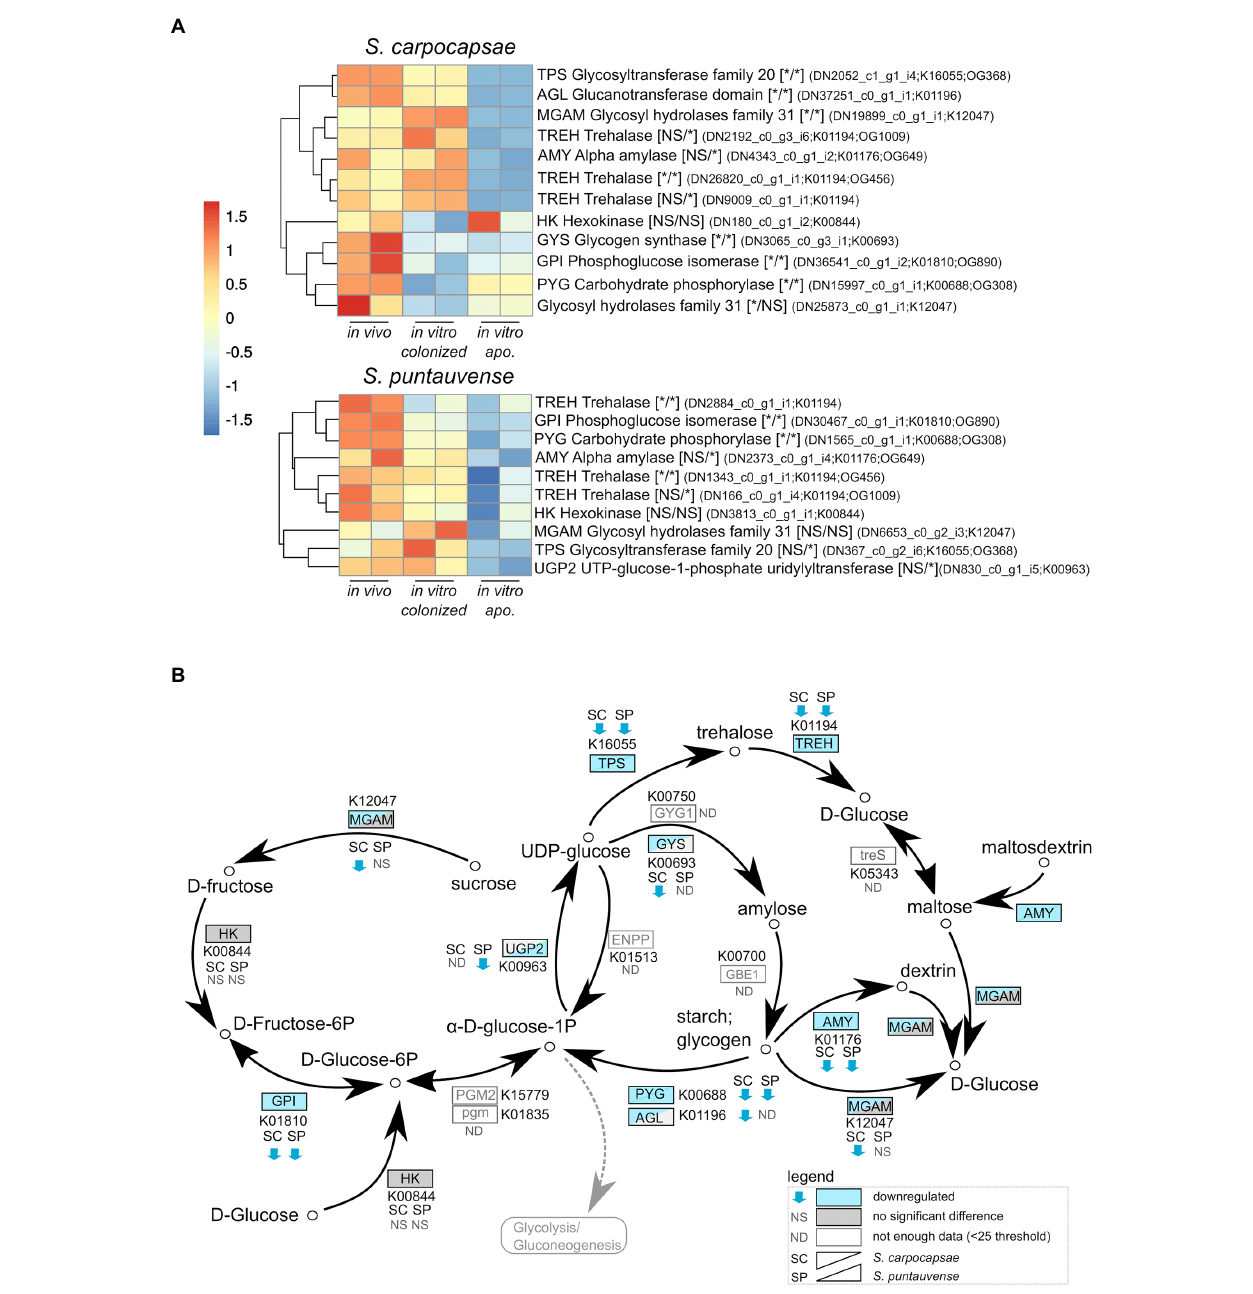
FIGURE 3 | Transcriptomic analysis of genes involved in starch and sucrose metabolism. (A) heatmap of transcripts involved in the starch and sucrose metabolism for Steinernema carpocapsae and Steinernema puntauvense produced by pheatmap (values are centered and scaled in the row direction). For each condition, two technical replicates are showed in the heatmap. On the right side of the heatmap supplementary information is indicated including: annotation of the transcription (based on hmmer); significance of differentially expression based on cuffdiff and edgeR (* for significantly different and NS for not significant): first value for the in vitro colonized rearing condition and the second value for the in vitro aposymbiotic rearing condition; the name of the transcript; the KEGG pathway detected; when applicable the name of the orthogroup of the transcript shared between the two species (based on orthofinder analysis) is shown. (B) Map of the starch and sucrose metabolism pathway (ko00500), where the observed expression in the in vitro aposymbiotic reared IJs for both Steinernema species is